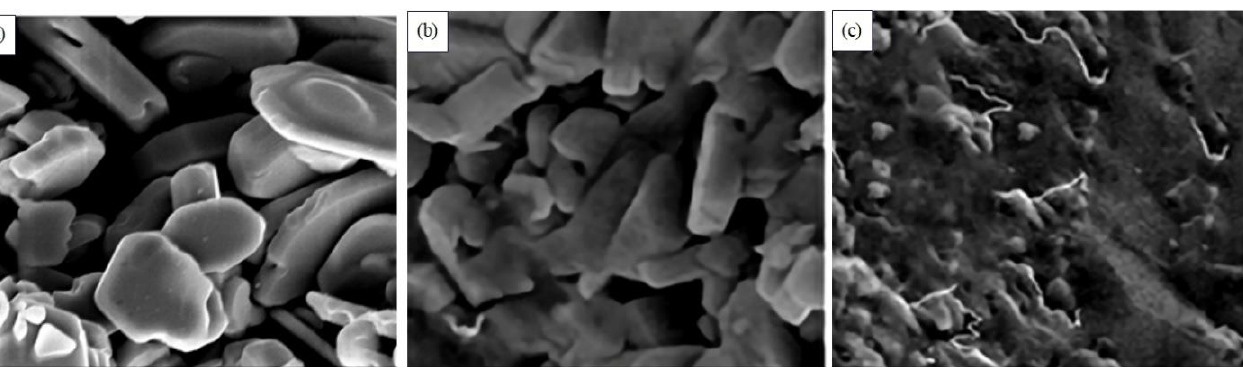
Figure 1. Graphic representation of the indentation used to evaluate fracture toughness.